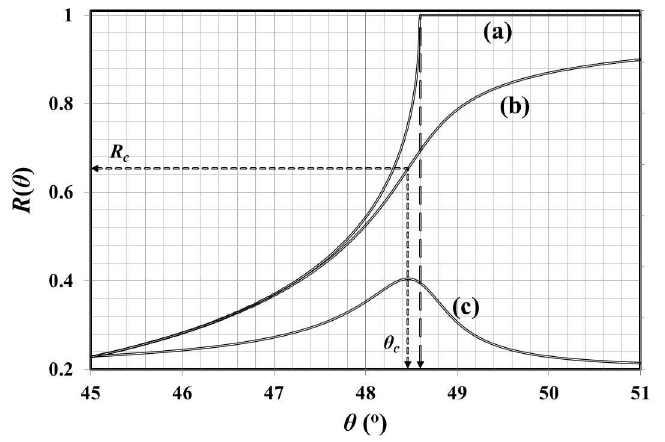
Figure 1. ( a ) Fresnel reflectance, R ( θ ) , profile, as a function of the incidence angle, θ , at an interface between a transparent sample and a transparent prism, such that the ratio of unknown refractive index to the known index is n / n o = 0.75. Long-dashed arrow indicates the location of the corre- sponding critical angle, θ c . ( b ) Fresnel reflectance profile at an interface between a lossy sample and a transparent prism, such that n r / n o = 0.75 and n i / n o = 0.005, where n r and n i are the real and inginary parts of the refractive index, respectively. Short-dashed arrows indicate the location of the corresponding critical angle and critical reflectance, R c . ( c ) The critical angle rests at the peak of the reflectance derivative, which is also depicted (in arbitrary